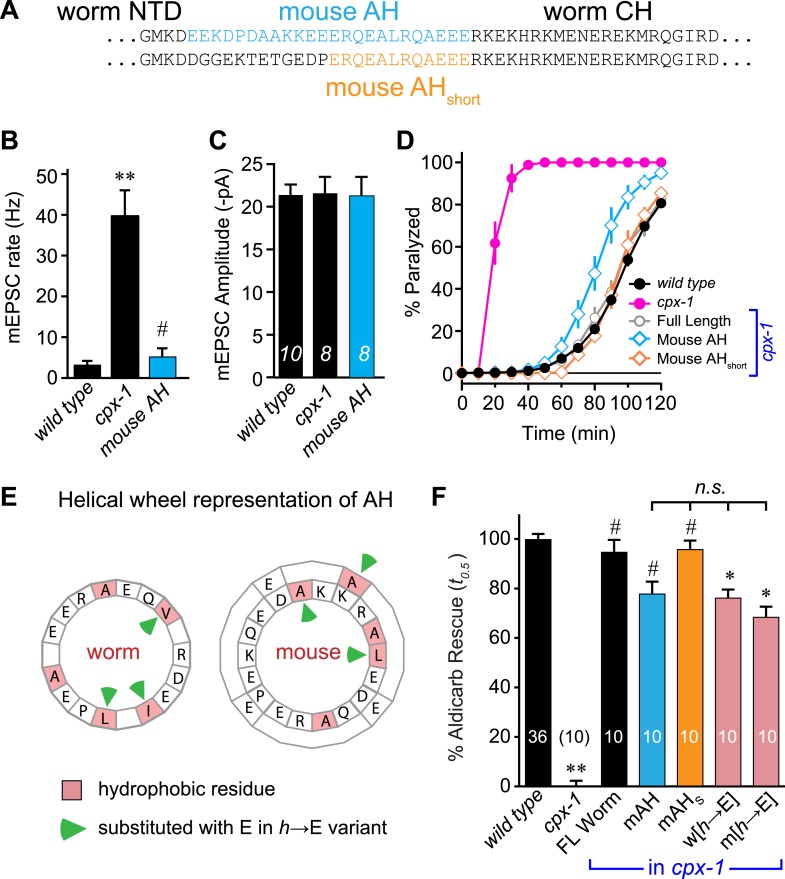
Mouse AH functions in worm CPX-1 and neither domain requires hydrophobic residues.(A) Two chimeric CPX-1 constructs substituting worm AH with the mouse AH. The long form (mouse AH) substitutes worm residues 26–49 with mouse residues 24–47 whereas the short form (mouse AHshort) substitutes worm residues 38–49 with mouse residues 36–47. Average spontaneous mEPSC rates (B) and amplitudes (C) for wild-type, cpx-1, and transgenic rescue of cpx-1 expressing the mouse AH chimera (mouse AH, blue). (D) Average paralysis time course in 1 mM aldicarb for wild-type (black filled circles), cpx-1 (pink filled circles), full-length rescue (gray open circles), mouse AH rescue (blue open diamonds), and mouse AHshort rescue (orange open diamonds). (E) Worm and mouse AH domain residues shown on a helical wheel diagram with hydrophobic residues indicated in red and hydrophobic substitutions with glutamate indicated with green arrow heads. (F) Percent rescue of wild-type paralysis kinetics using the time to 50% paralysis (t0.5) for the five genotypes shown in D as well as a worm CPX-1 variant with V39E, I40E, L44E substitutions (w[h→E]) and a mouse AHshort variant with A40E, L41E, A44E substitutions (m[h→E]). Note that the residue positions are labeled based on their location in CPX-1 and mCpx1 respectively. Data are mean ± SEM with sample sizes as indicated on the bar graphs. Using Tukey–Kramer statistics for multiple comparisons, ** denotes significantly different from wild type, # significantly different from cpx-1 but not wild type, * significantly different from both wild type and cpx-1 (p < 0.01), n.s. is not significant.